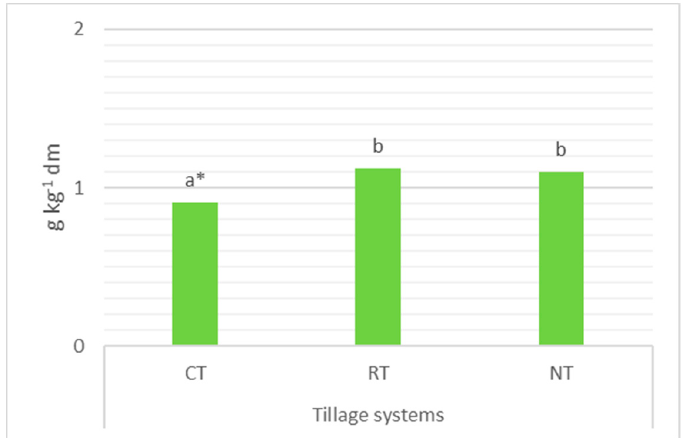
Figure 5. Content of total nitrogen in the 0–25 cm soil layer depending on the tillage system (average of 2014–2016). * a—Means denoted with the same letters do not differ significantly, p < 0.05. Agriculture 2020 , 10 , x FOR PEER REVIEW